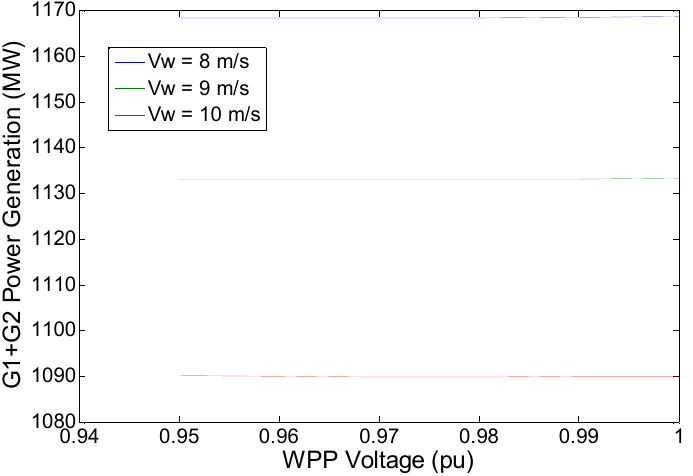
Figure 14. Variation of WPP reactive power output.